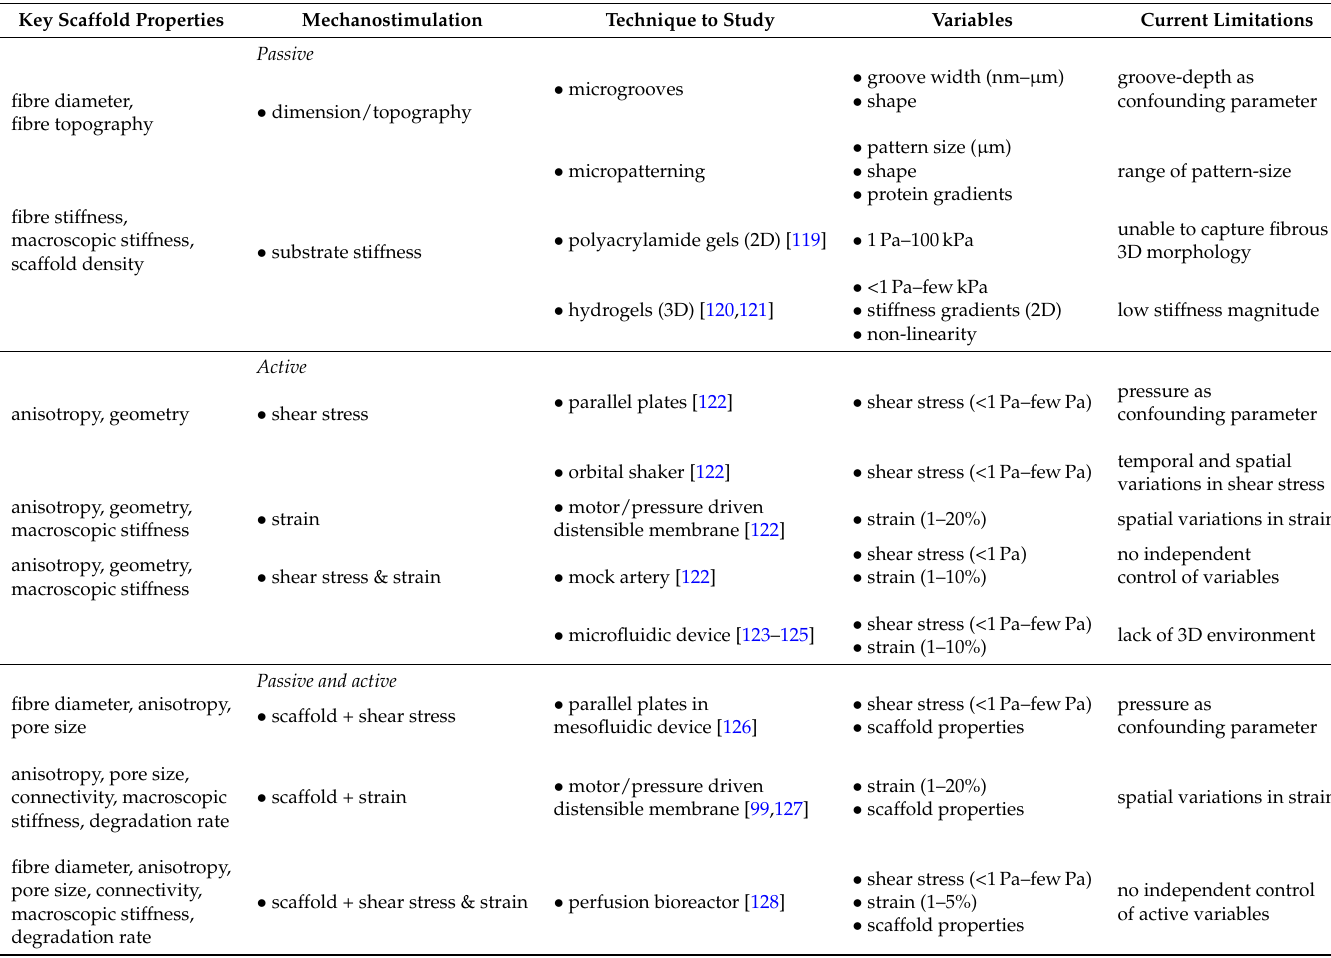
Table 3. Selection of currently available experimental platforms that are used to delineate the role of passive and active cues in the context of optimizing key scaffold